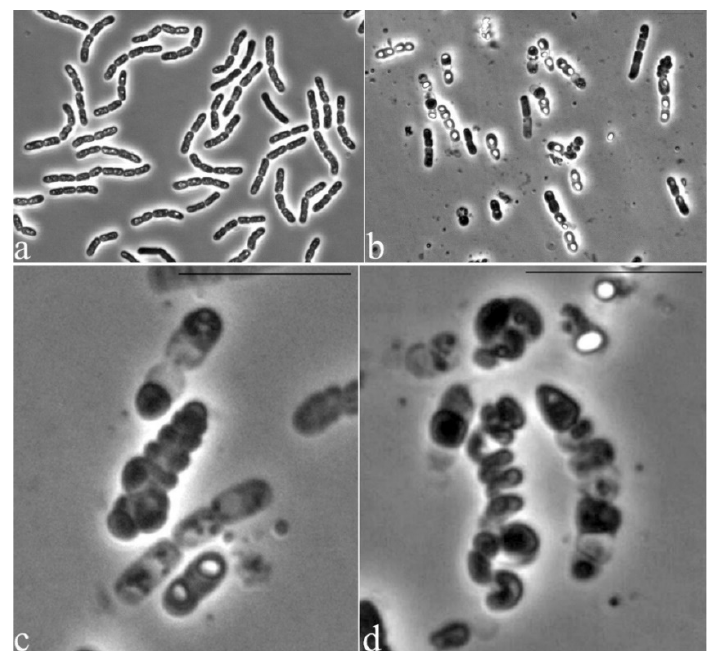
Figure 2. Bacillus aryabhattai str. 25 in the exponential growth phase (( a ) 1 day of growth; ( b – d ) 2 days of growth). Cluster of multiple small irregular cells ( c ). Spirally twisted elongated cell ( d ). Light microscopy. Phase contrast. Bar—10 µm.